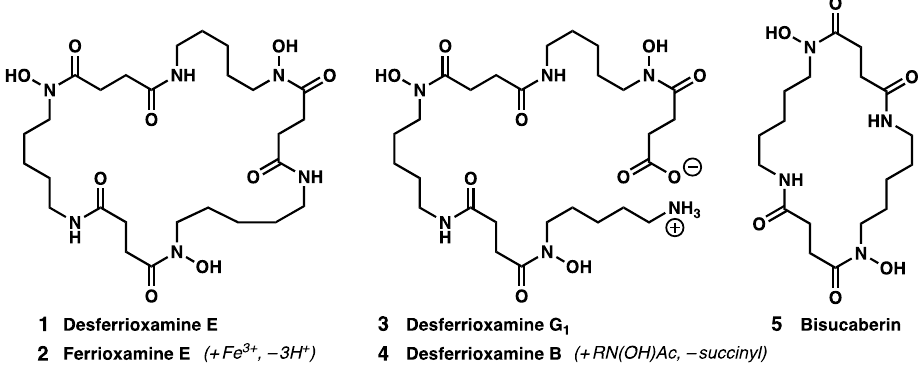
Figure 1. Various hydroxamate ferric-binding siderophores referenced throughout this study.